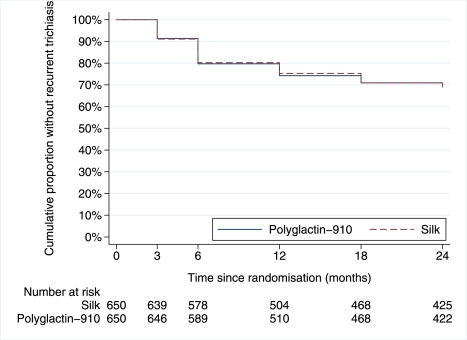
Kaplan-Meier graph of time to failure.